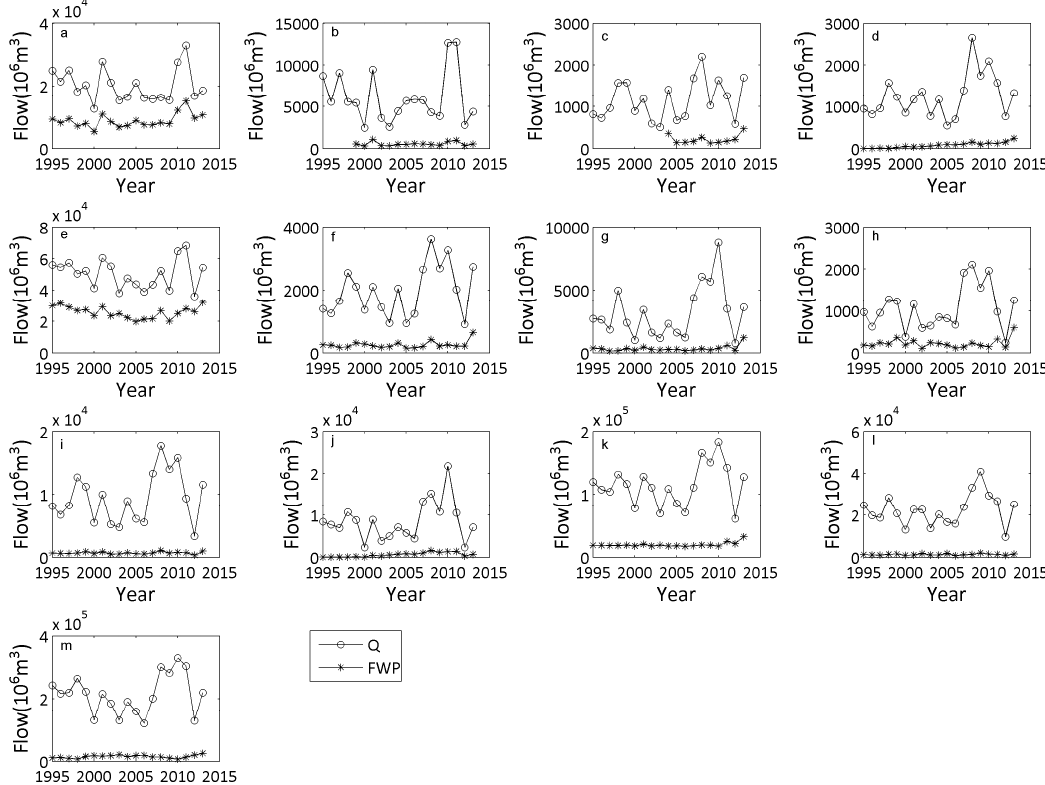
Figure 3. Freshwater provision versus total flow between 1995 and 2013 for 13 watersheds in UMRB: Twin Cities ( a ); Lower Minnesota ( b ); Turkey ( c ); Maquoketa ( d ); Copperas-Duck ( e ); Lower Wapsipinicon ( f ); Skunk ( g ); Upper Iowa ( h ); Lower Iowa ( i ); Lower Des Moines ( j ); Peruque-Piasa ( k ); Lower Illinois ( l ); Upper Mississippi-Cape Girardeau ( m ).